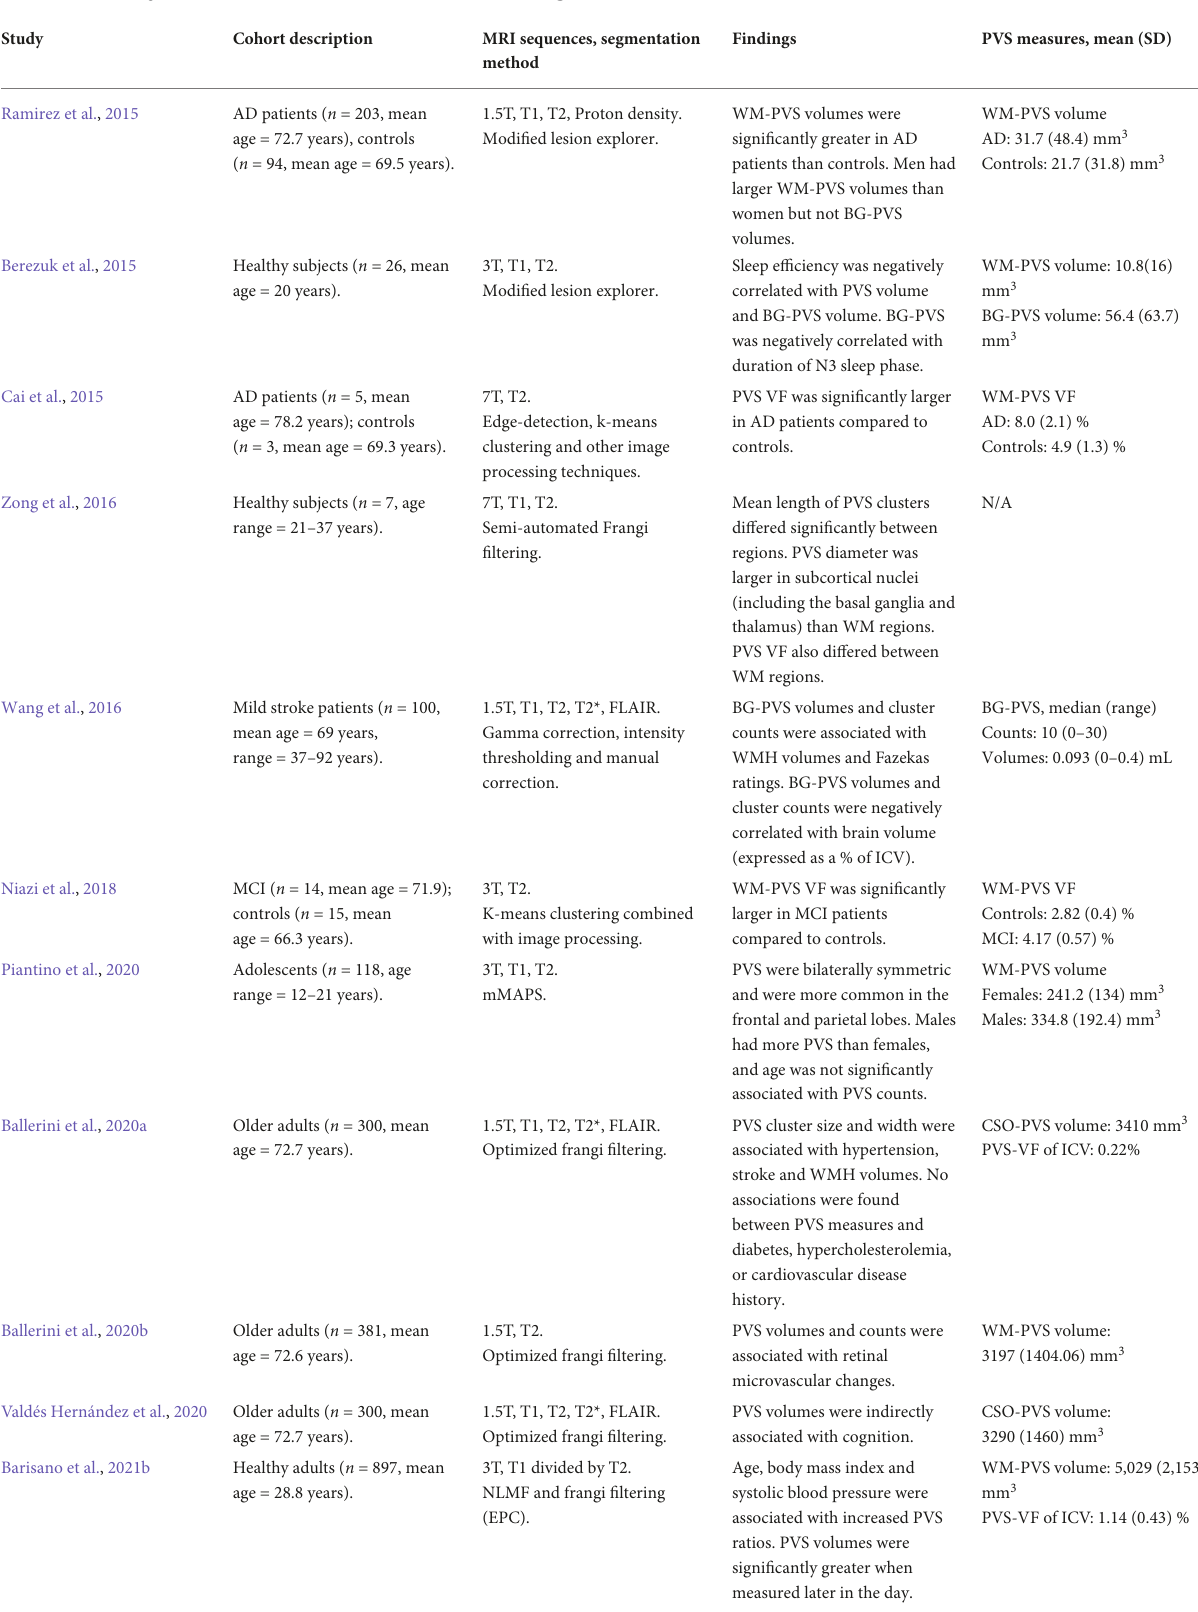
TABLE 2 Summary of the PVS research that has resulted from 3D